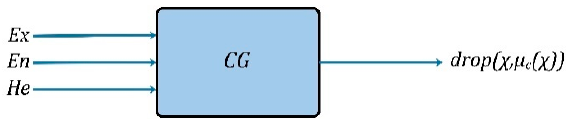
Figure 4. Forward Cloud Generator.